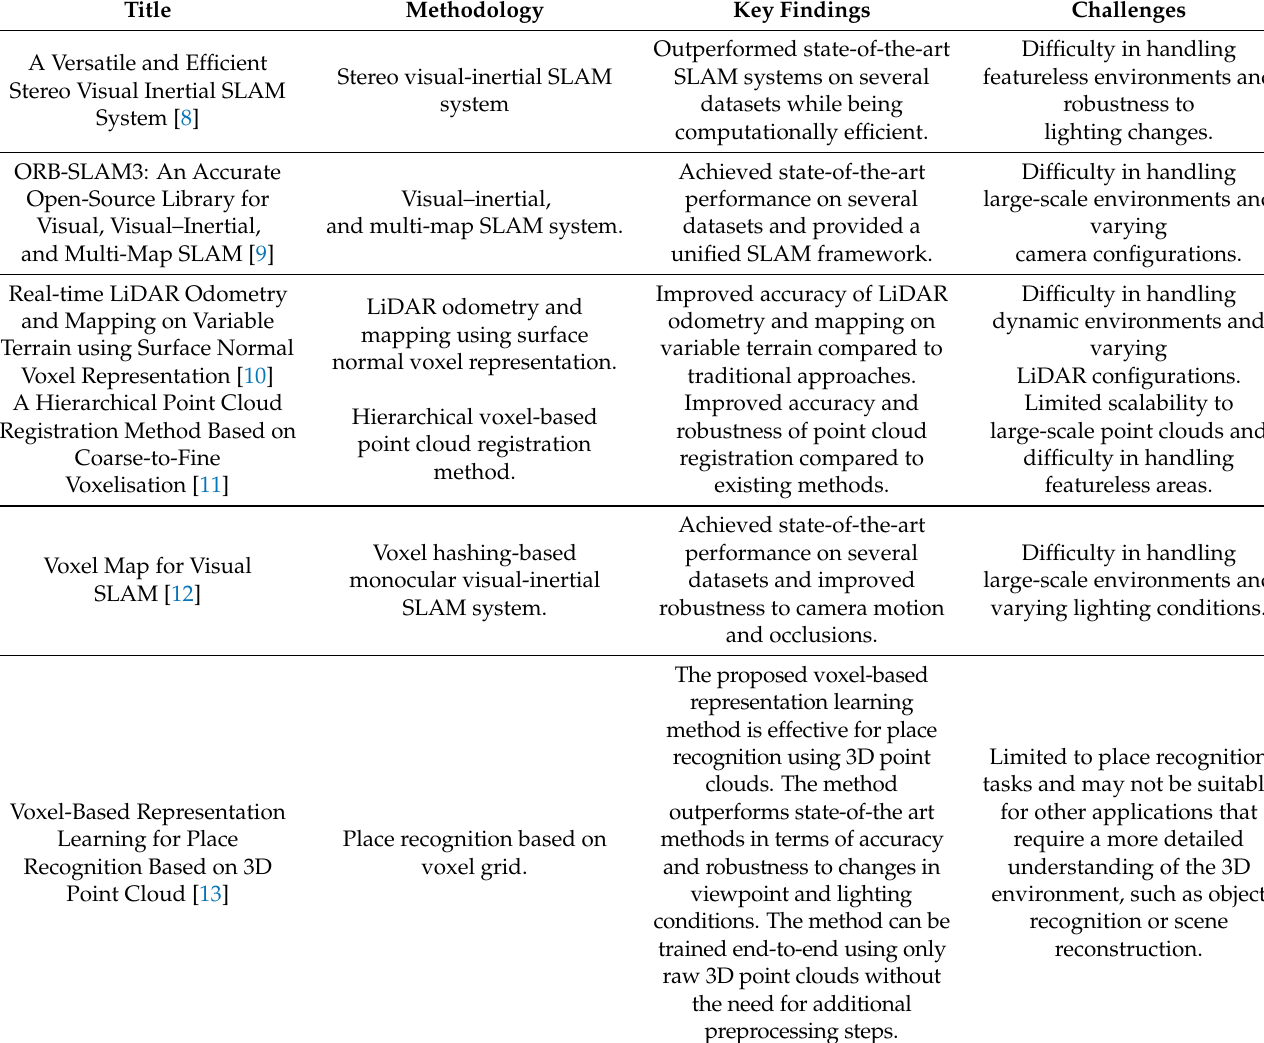
Table 1. Summary of recent work in the field with key findings and